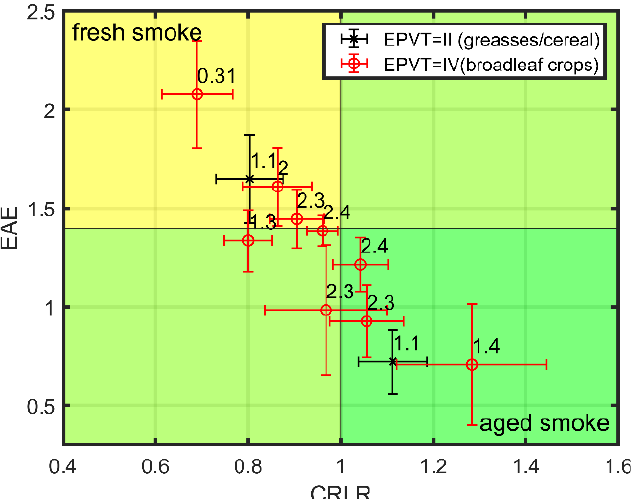
Figure 9. EAE versus CR LR . The upper left corner shows typical values for fresh smoke, while the lower right corner shows typical values for aged smoke. The number represents the travel time in days.